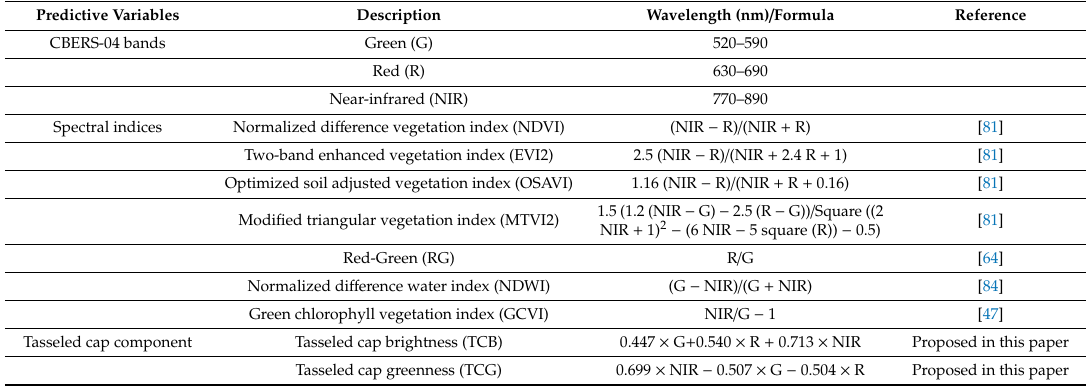
Table 2. Predictive variables used in mapping the quasi-circular vegetation